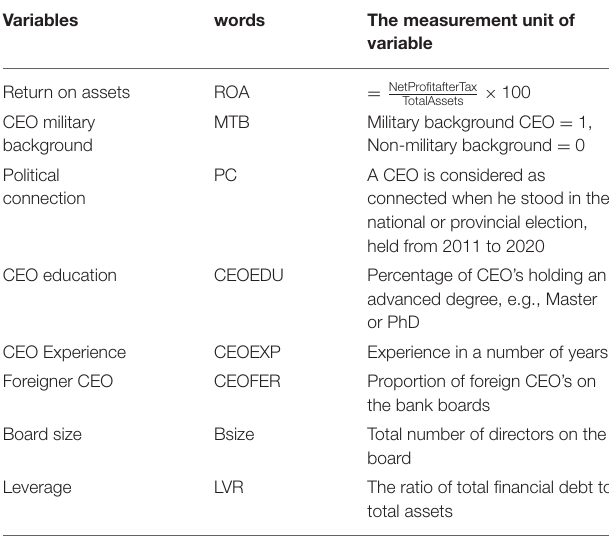
TABLE 1 | Definition of key